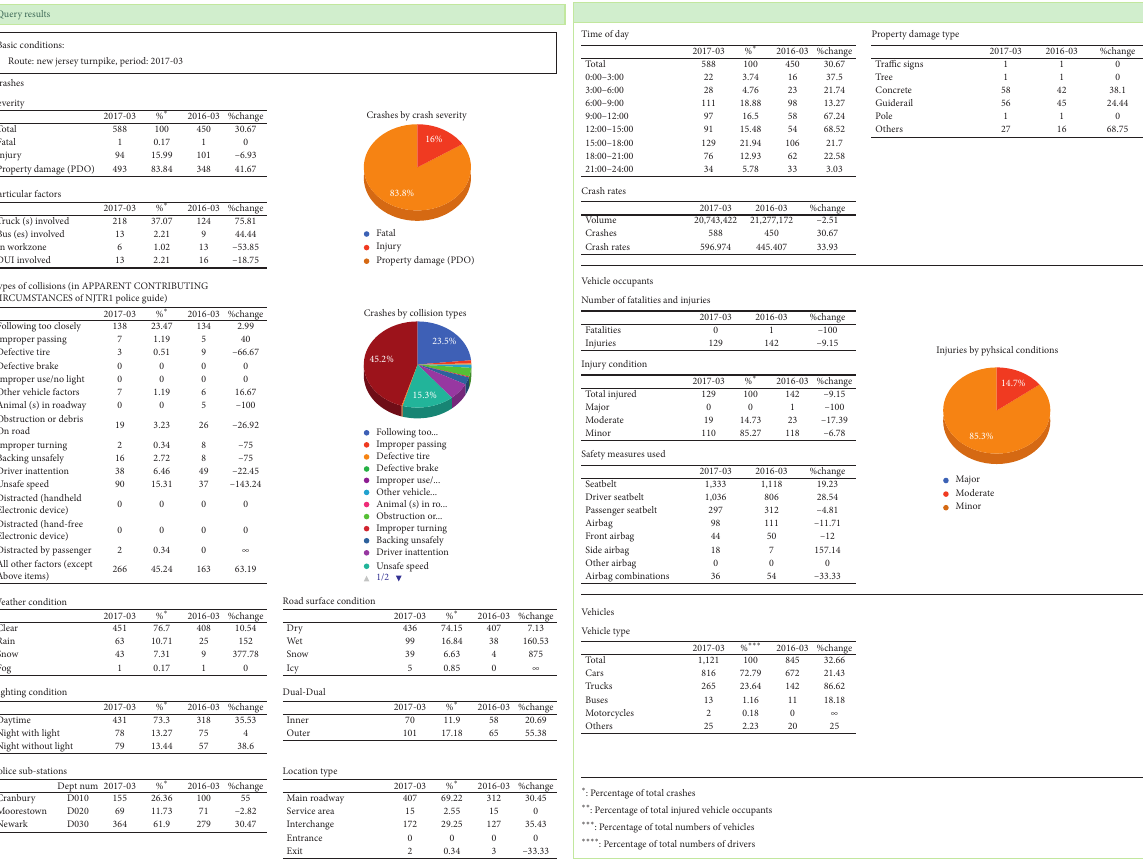
Figure 1: Crash report of the tool (March 2017 data).